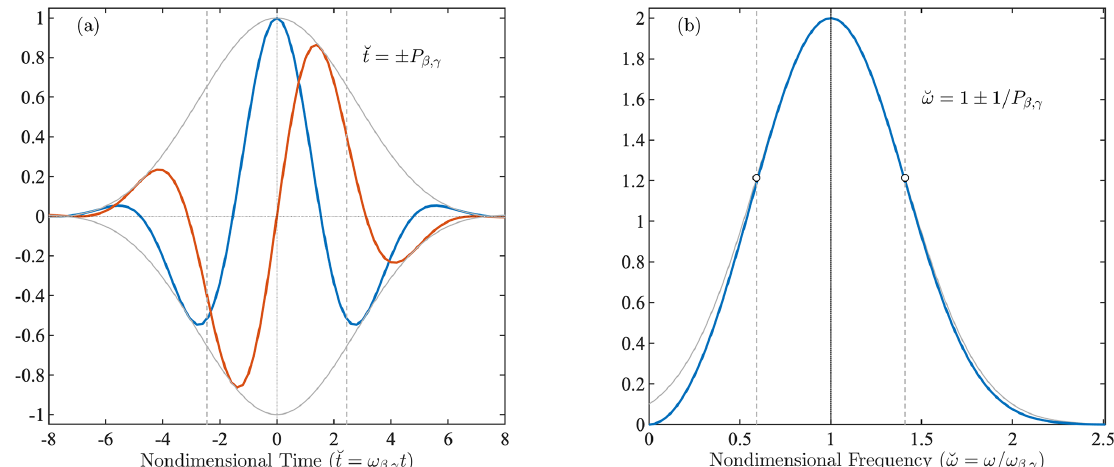
Figure 7. A generalized Morse wavelet ψ β,γ (t) with the choice (β,γ) = ( 2 , 3 ) in (a) the time domain and (b) its Fourier transform (cid:57) β,γ (ω) . Both time and frequency have been nondimensionalized, as ˘ t ≡ ω β,γ t and ˘ ω ≡ ω/ω β,γ , respectively. In panel (a) , the blue and orange lines are the real and imaginary parts, respectively, of ψ β,γ (cid:0) ˘ t (cid:1) , while the thin gray lines are plus or minus the wavelet modulus | ψ β,γ (cid:0) ˘ t (cid:1) | . Here the time-domain wavelet has been rescaled to have unit amplitude. In panel (b) , the thin gray line is the Gaussian approximation in Eq. (45). Vertical dashed lines in both panels are measures of the wavelet half-width based on P β,γ , as described in the text, while dots in (b) are the wavelet value at ˘ ω = 1 ± 1 /P β,γ . Dotted lines mark ˘ t = 0 and zero magnitude in (a) , and the wavelet peak frequency of ˘ ω = 1 in (b)